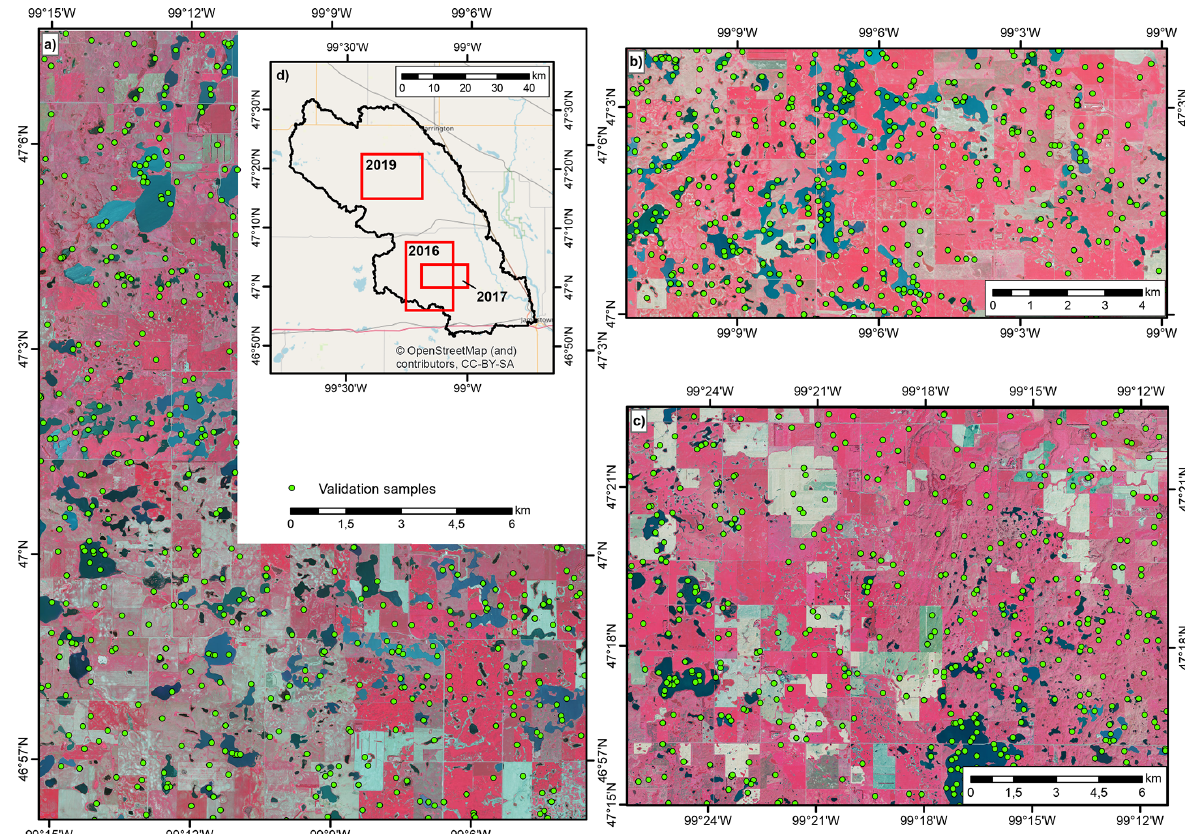
Figure A1. NAIP false-colour composites (R – near-infrared, G – red and B – green) acquired in (a) 2016, (b) 2017 and (c) 2019. Green dots show sample points used for the validation of waterbodies derived from Sentinel-1. (d) Location of the NAIP footprints inside the study area.